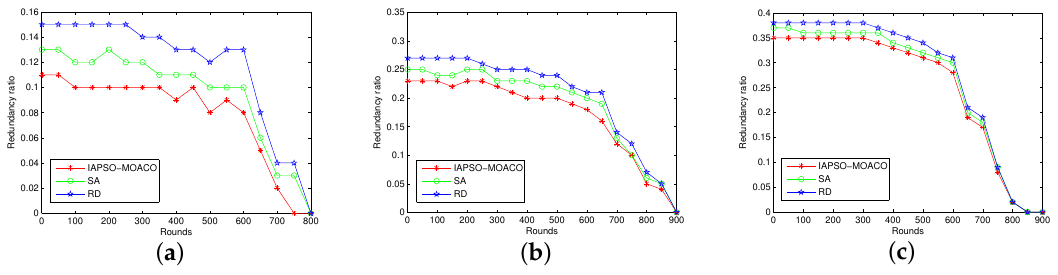
Figure 5. Comparison in terms of redundancy ratio with 100 to 200 nodes. ( a ) 100 nodes with 6 cluster heads; ( b ) 150 nodes with 9 cluster heads; ( c ) 200 nodes with 12 cluster heads.